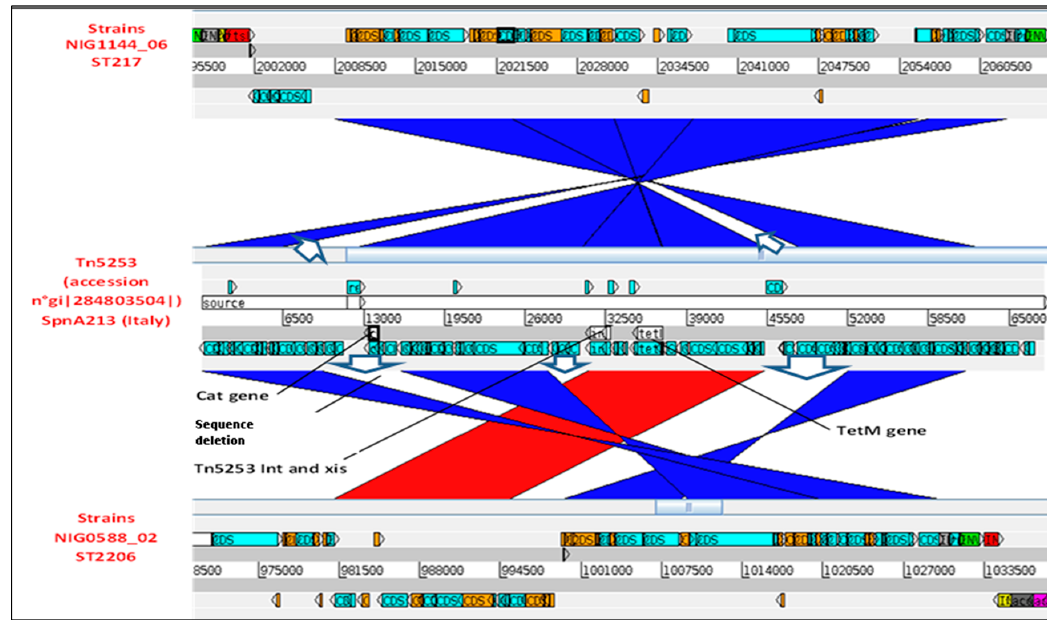
Figure 4. Comparative analysis of Tn 5253 mobile element (accession N° gi|284803504| to Tn 5253 like sequence from genomes of type 1 clinical Streptococcus pneumoniae strains NIG0588_02 representing isolates susceptible to chloramphenicol and strain NIG1144_06 that was chloramphenicol resistant.